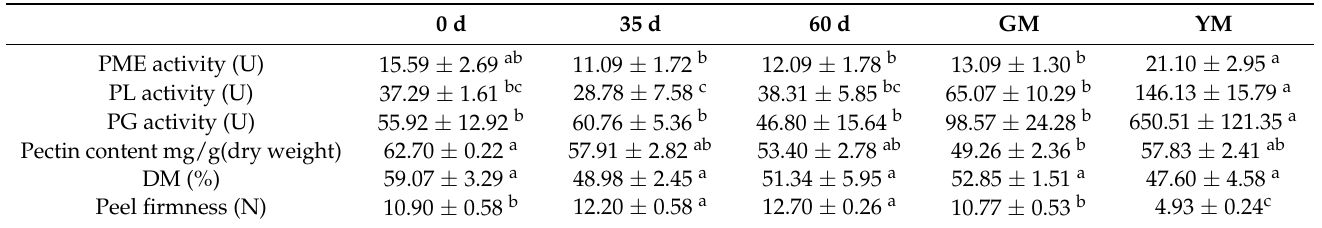
Table 1. The changes in the activities of HG degradation enzymes and fruit properties in banana ( Musa spp. AAA) peel during fruit development and